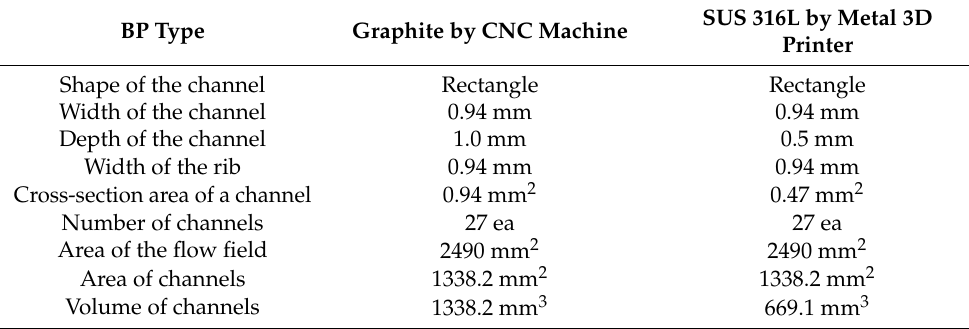
Figure 4. Two BPs for comparison: ( a ) Graphite (W0.94, R0.94, and D1.0) by CNC machine; ( b ) SUS 316L (W0.94, R0.94, and D0.5) by metal 3D printer. Table 6. Configuration data of two bipolar plates for comparison.